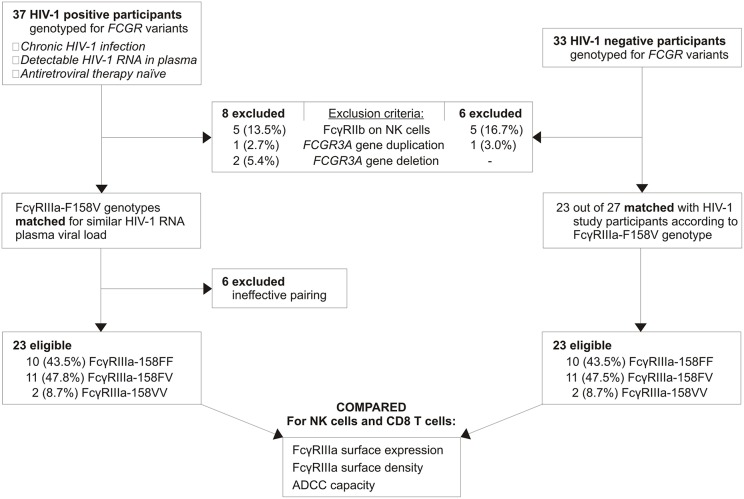
Study participant selection.